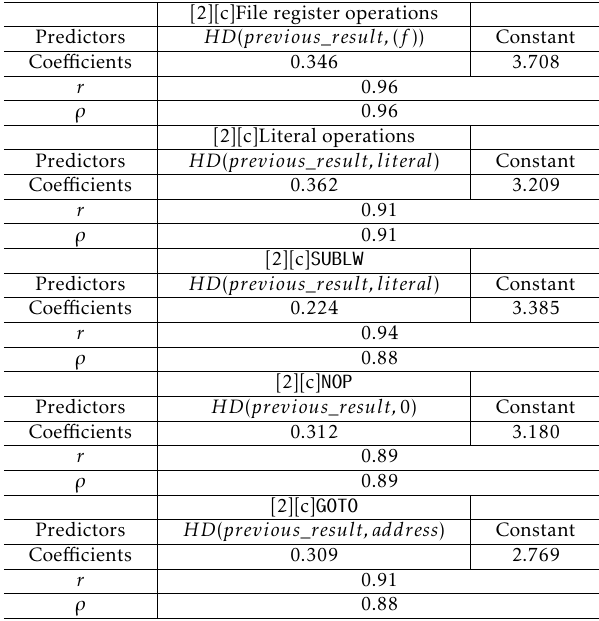
Table 4. Regression analysis of EM radiation in